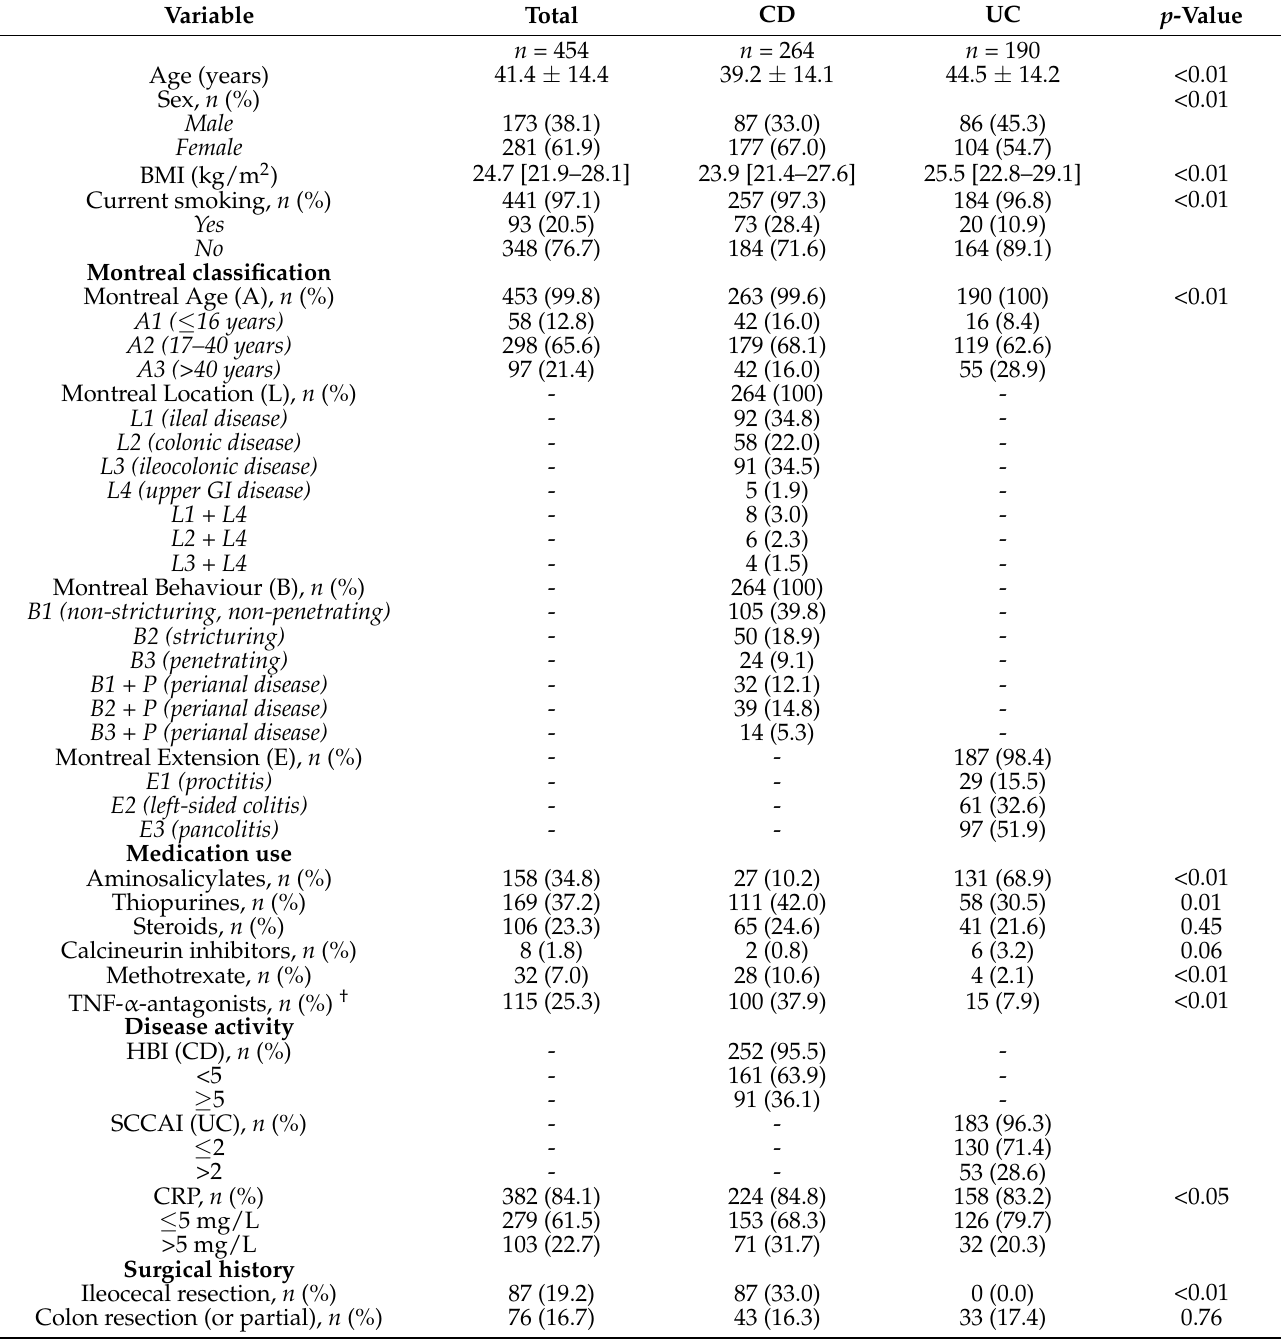
Table 1. Demographic and clinical characteristics of the full study population and for patients with CD and UC